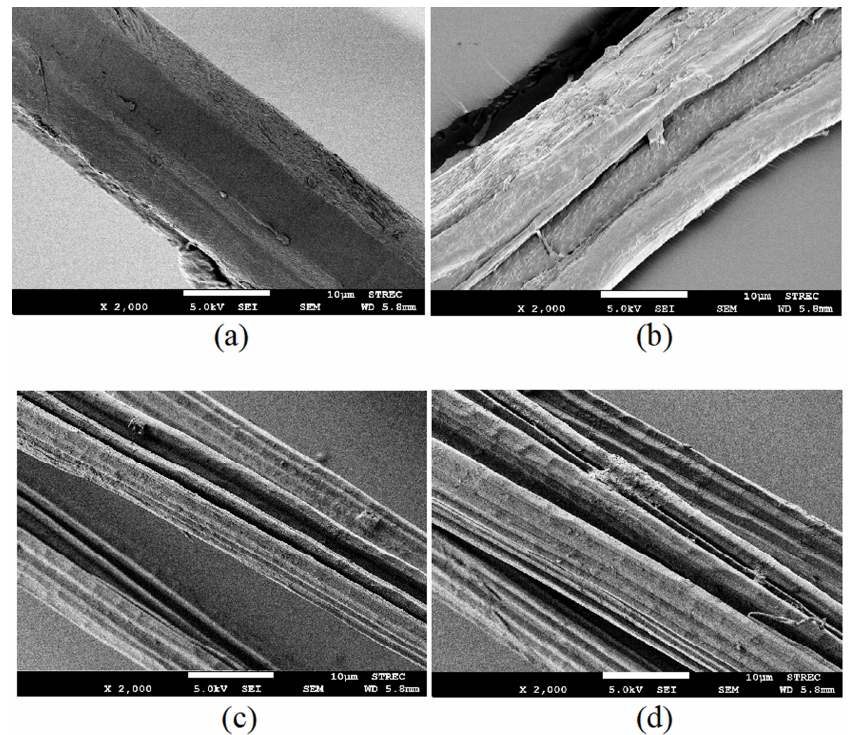
Figure 3. FESEM images of ( a ) JF un , ( b ) A-JF, ( c ) A-St-JF and ( d ) A-Si-JF.